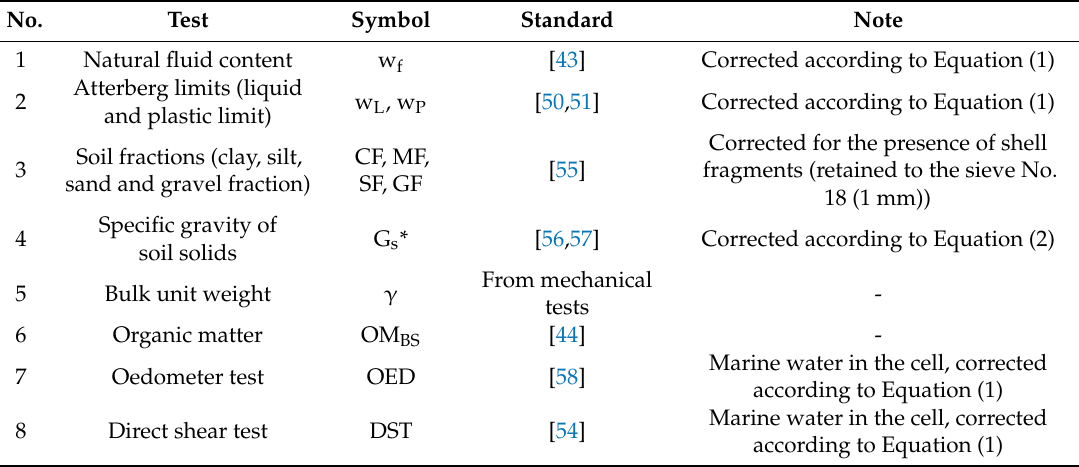
Table 2. Synthesis of the geotechnical tests performed and of standard methods and corrections